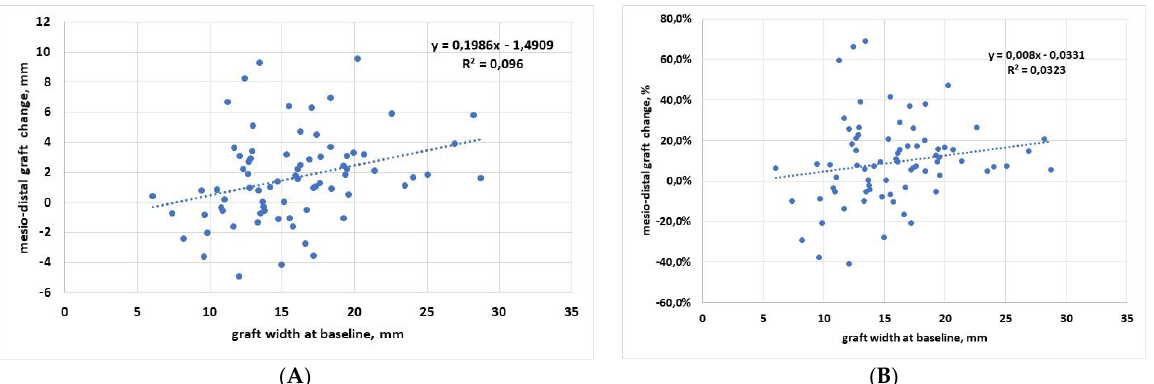
Figure 3. Regression analysis for mesiodistal dimension change respect to baseline. ( A ) Data in mm; ( B ) data in percentage.